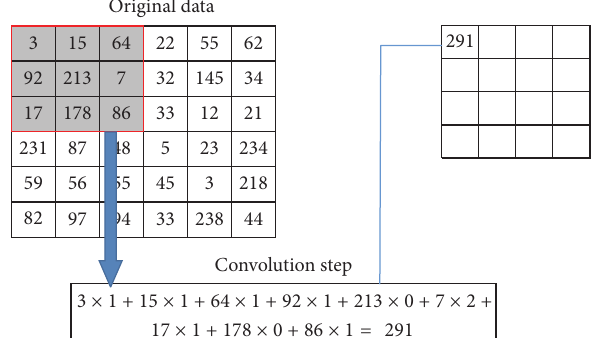
Figure 5: An example of convolution calculation.